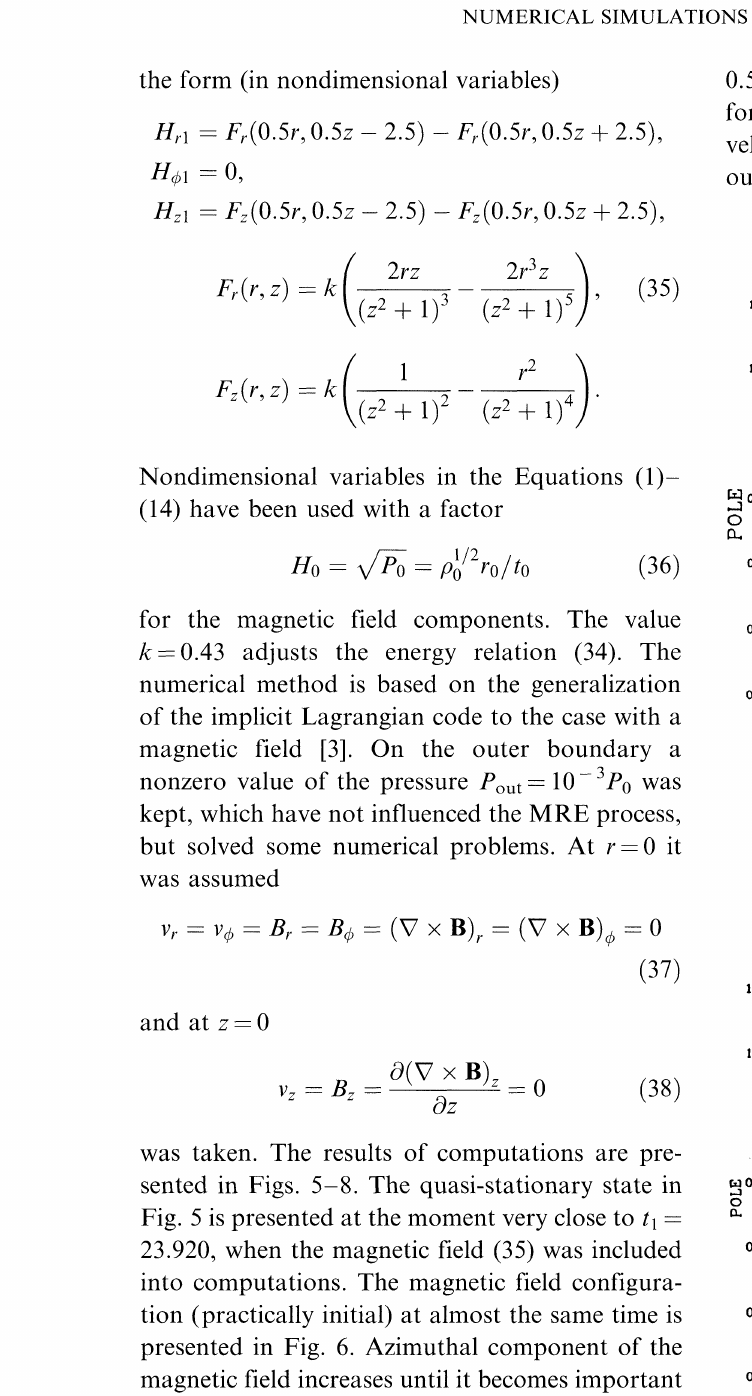
Magnetic field TIME= 23.937901